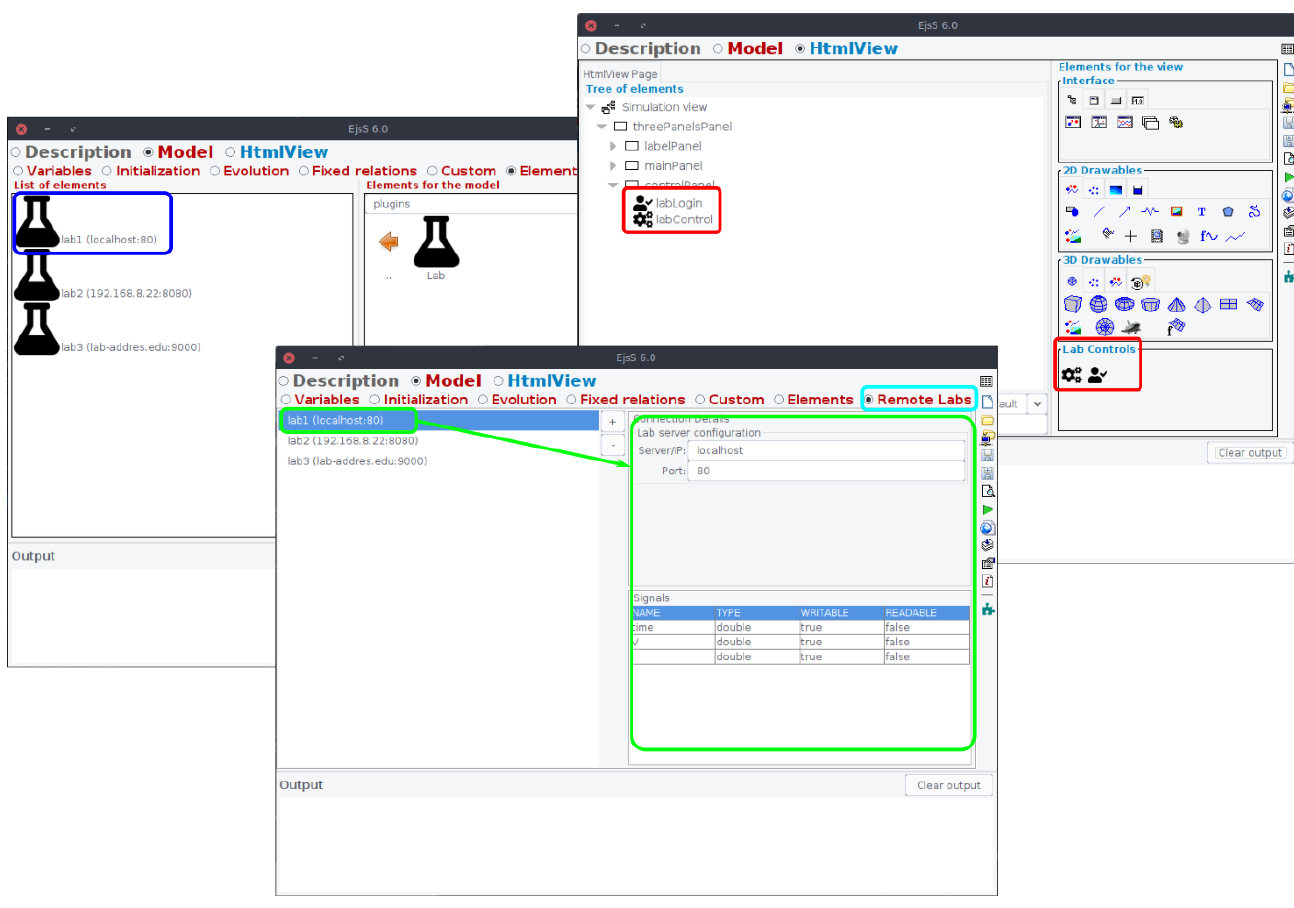
Figure 9. EJsS adapted with the Remote Laboratory